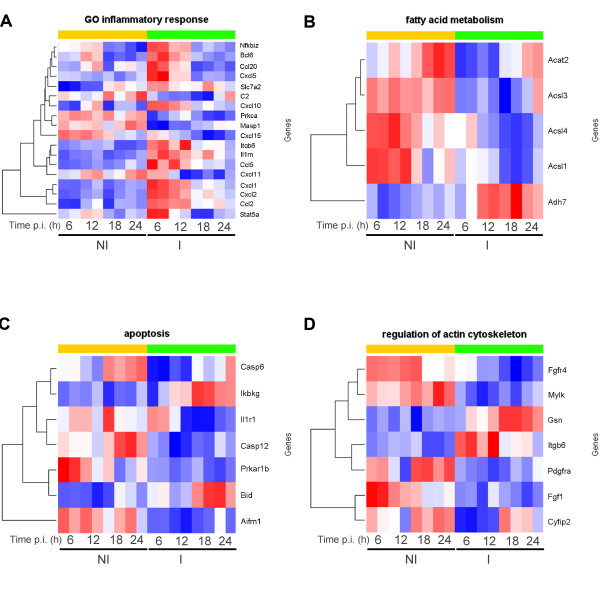
Heatmaps of DE genes in P. berghei infected vs. non-infected cells. for (A) Inflammatory response (GO:0006954), (B) Fatty acid metabolism (KEGG metabolic pathway mmu00071), (C) Apoptosis (KEGG metabolic pathway mmu04210), (D) Regulation of actin cytoskeleton (KEGG metabolic pathway mmu04810).